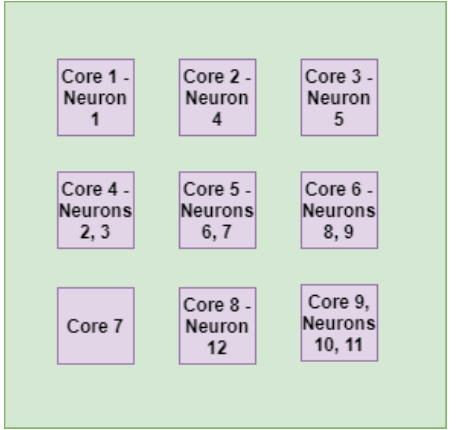
Figure 9. Level-2 mapping for nine-cores architecture using multilevel mapping